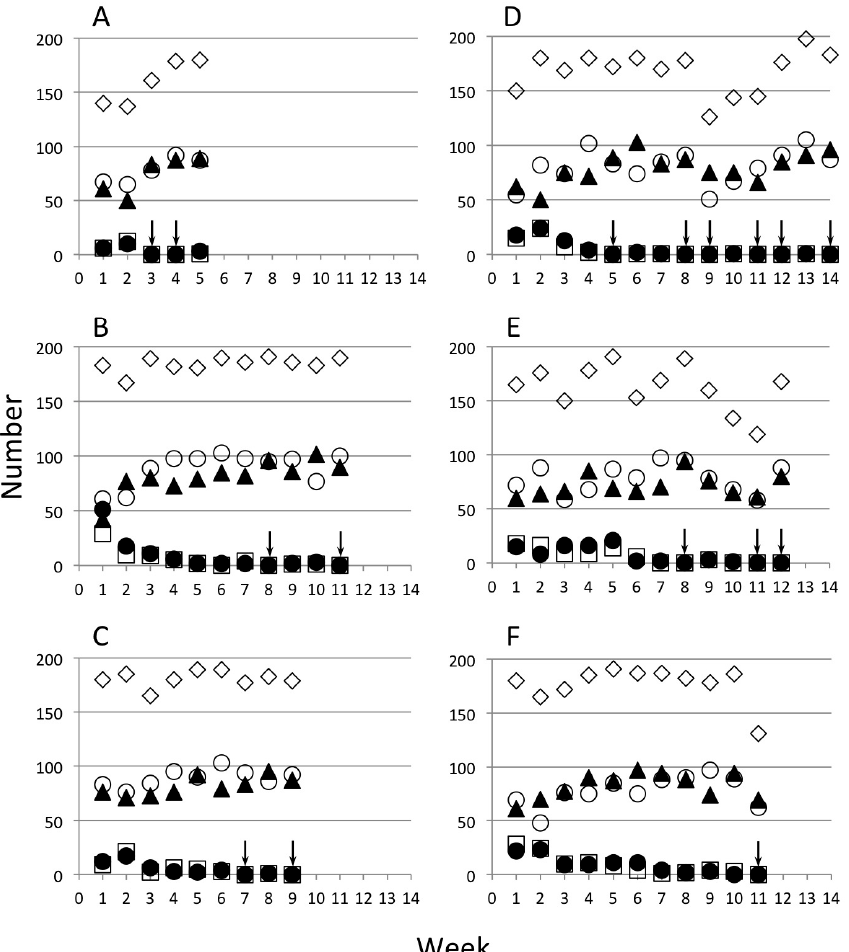
Figure 4. Restocking of Ag(DSM)2 cages. The actual numbers of pupae returned each week and the totals are represented. Two frequencies of seeding of hemizygous transgenic females were made: 20% ( A – C ), 50% ( D – F ). Transgenic males ( ● ), transgenic females ( ☐ ), non-trangenic males ( ▲ ), non-transgenic females ( ○ ), and the total ( ◇ ) . Arrows indicate weeks in which no GM mosquitoes were detected.